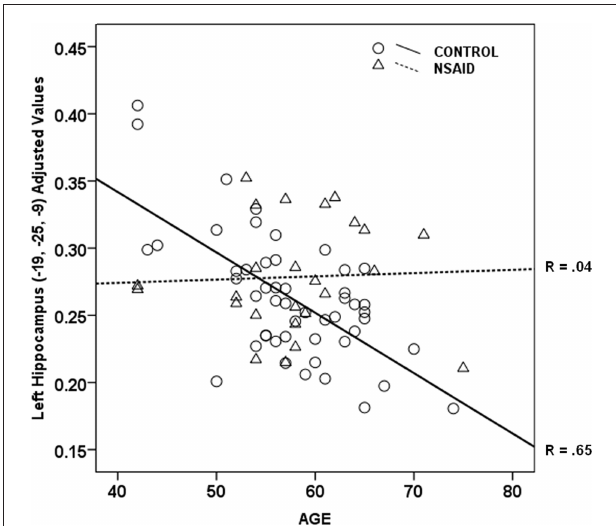
FIguRe 2 | Age by group interaction plot. Non-users controls showed a strong relationship between older age and lower hippocampal volume ( r = 0.65) compared to the NSAID user group ( r = 0.04). Values plotted below are from left hippocampus ( Y axis) were adjusted for total gray